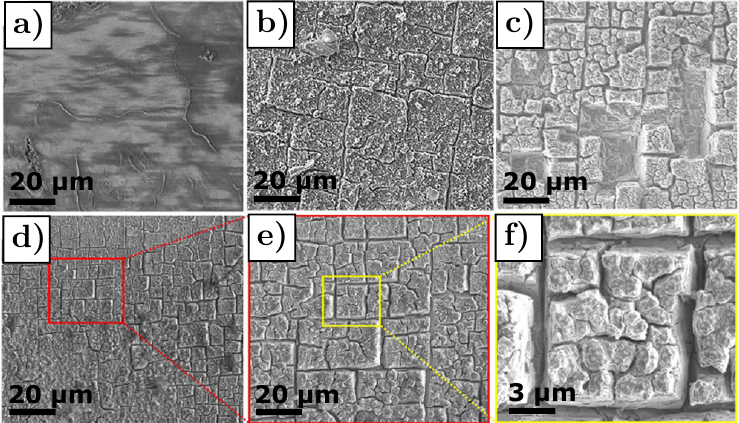
Figure 6. Crack growth as a function of lithiation cycles in thin film after ( a ) 3, ( b ) 8, and ( c ) 50 cycles. ( d – f ) Detail of crack pattern after 30 lithiation cycles. Reprinted with permission by Nature Publishing Group from [55], Copyright